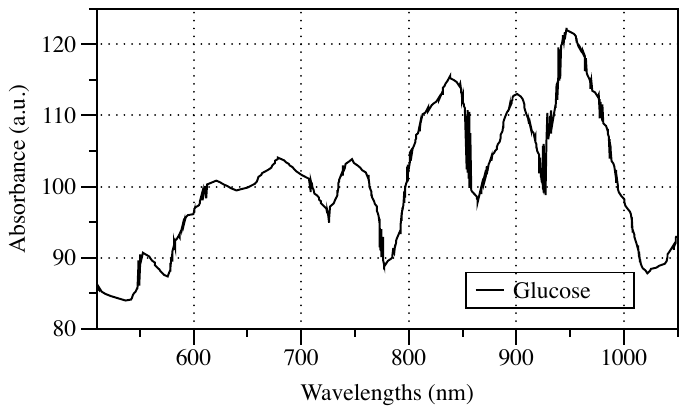
Figure 1. The absorption spectrum of aqueous glucose solution, deducted water background, measured by UV-3600 Plus (Shimadzu, Kyoto, Japan, 2018) ultraviolet-near infrared (UV-NIR) spectrometer, which has an absorption peak at about 930